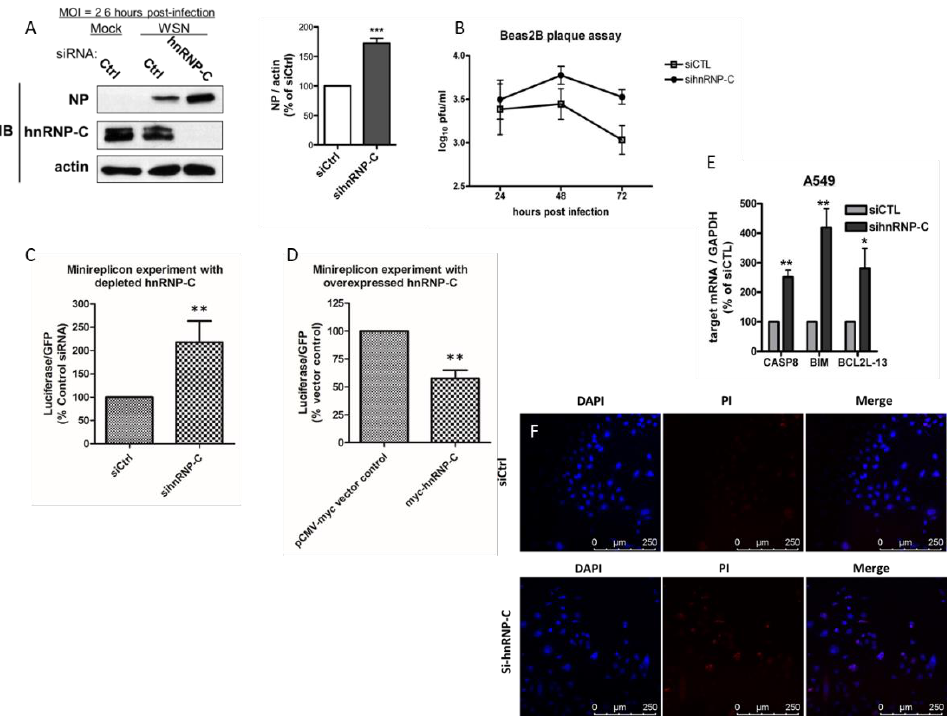
Figure 3. ( A , B ) Growth of A/WSN/1933 (H1N1) in hnRNP-C-silenced Beas2B cells was found to be enhanced compared with control Beas2B cells. By Western blotting, we observed a rise in protein level for NP at 6 h post-infection by A/WSN/1933 (H1N1) if endogenous hnRNP-C was transiently knocked down prior to infection. Growth enhancement was exacerbated at later time points, as revealed by plaque assay; ( C ) upon hnRNP-C depletion by hnRNP-C-targeting siRNA, luciferase signal rose to 218% of control siRNA, reflecting an enhanced polymerase activity; ( D ) when hnRNP-C was overexpressed, a drop in luciferase signal was observed, reflecting a suppression in polymerase activity, further suggesting hnRNP-C to be a negative regulator of IAV; ( E ) through real-time PCR, expression of pro-apoptotic factors caspase 8 (CASP8), BCL2-like 11 apoptosis facilitator (BCL2L11), and BCL2-like 13 apoptosis facilitator (BCL2L13) were all upregulated upon transient knockdown of endogenous hnRNP-C; ( F ) A549 transfected with either control or specific hnRNP-C siRNA were double- stained with 4′,6 -diamidino-2-phenylindole (DAPI) and propidium iodide (PI). More cells were PI-stained upon hnRNP-C depletion. Magnification at 20×. For panels A – E, * p < 0.05, ** p < 0.01, *** p < 0.001 in two-tailed Student’s t -test, n =